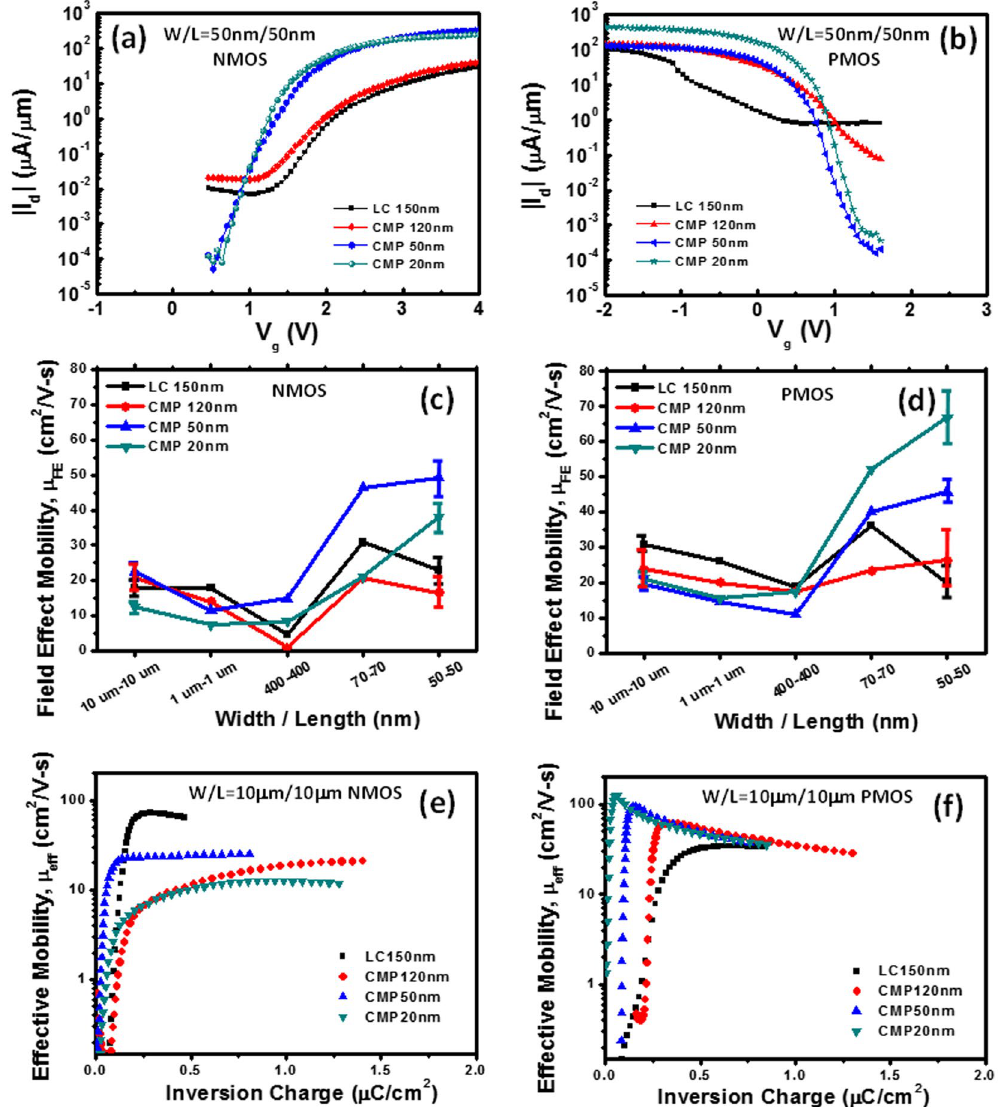
Figure 3. ( a and b ) I-V behaviors of NMOSFETs and PMOSFETs with the channel width/length (50 nm/50 nm) at different crystallized poly-Si thin films as channel layers. ( c and d ) Field effect mobility ( m FE ) of NMOSFETs and PMOSFETs as the function of channel lengths at different crystallized poly-Si thin films as channel layers. ( e , f ) Effective mobility ( m eff ) of NMOSFETs and PMOSFETs with a long channel width/length of 10 m m/10 m m at different crystallized poly-Si thin films as channel